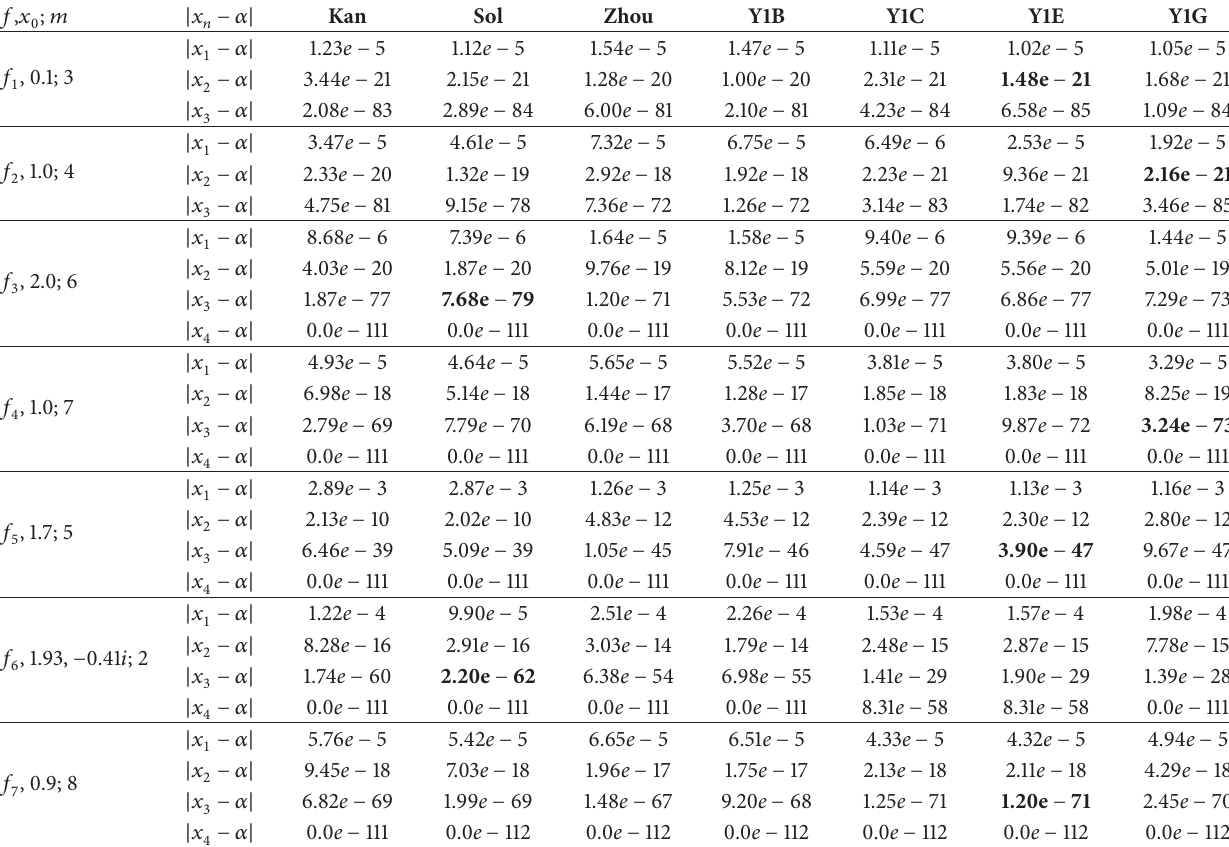
Table 8: Comparison of |𝑥 𝑛 − 𝛼| among existing and proposed (Case 1) multiple-root